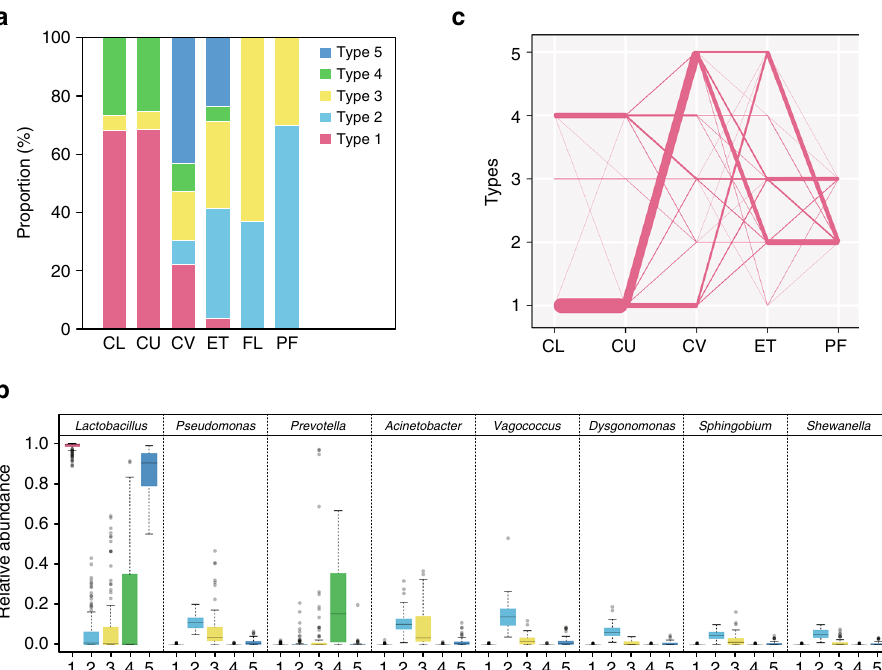
Fig. 4 Community types of the vagino-uterine microbiota. a Distribution of samples among the fi ve community types at each body site ( n = 94 CL, 95 CU, 95 CV, 80 ET, 93 PF, 9 FLL and 10 FRL, Supplementary Data 1). b Relative abundances of the top 8 most abundant genera in the 5 community types. The boxes denote the interquartile range (IQR) between the fi rst and third quartiles (25th and 75th percentiles, respectively), and the line inside the boxes denote the median. The whiskers denote the lowest and highest values within 1.5 times the IQR from the fi rst and third quartiles, respectively. Circles represent data points beyond the whiskers. c Community types connected between neighbouring sites according to individual subjects. Due to the small sample size, results for the fallopian tubes were plotted in a separate graph (Supplementary Fig. 7c). The width of each line indicates the number